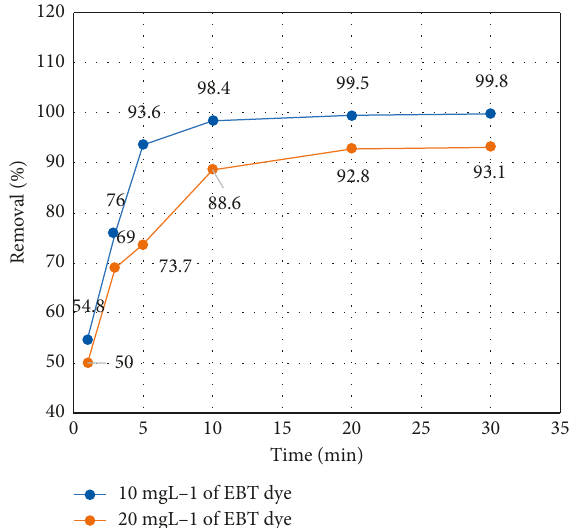
Figure 8: Influence of contact time on the adsorption of 10mg · L − 1 EBT dye by 0.1 g/50mL NSG nanocomposite at a pH of 3 and a contact time of 20min.